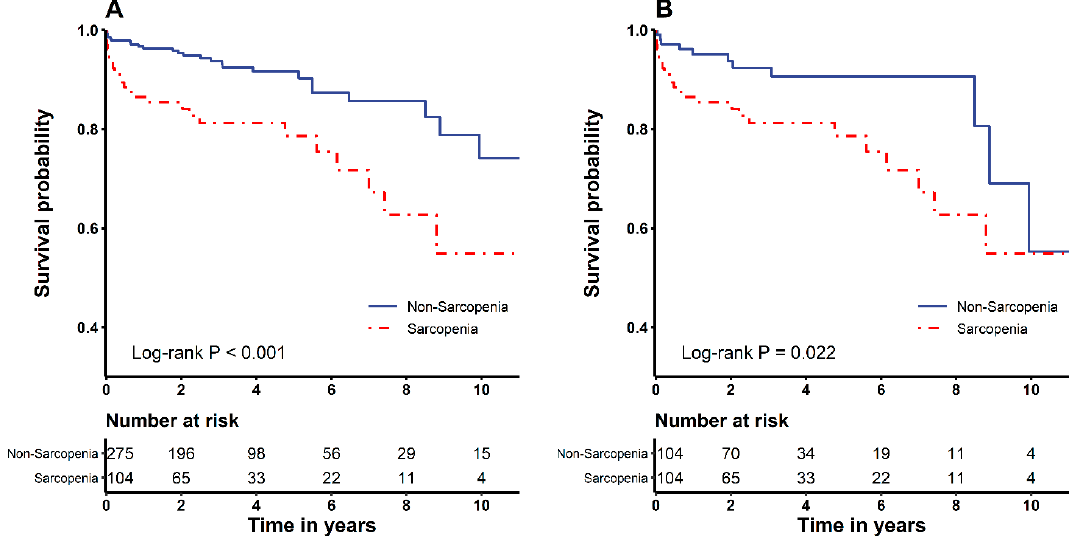
Figure 1. Kaplan–Meier survival curves of the sarcopenia and non-sarcopenia groups before ( A ) and after ( B ) propensity score matching analysis.